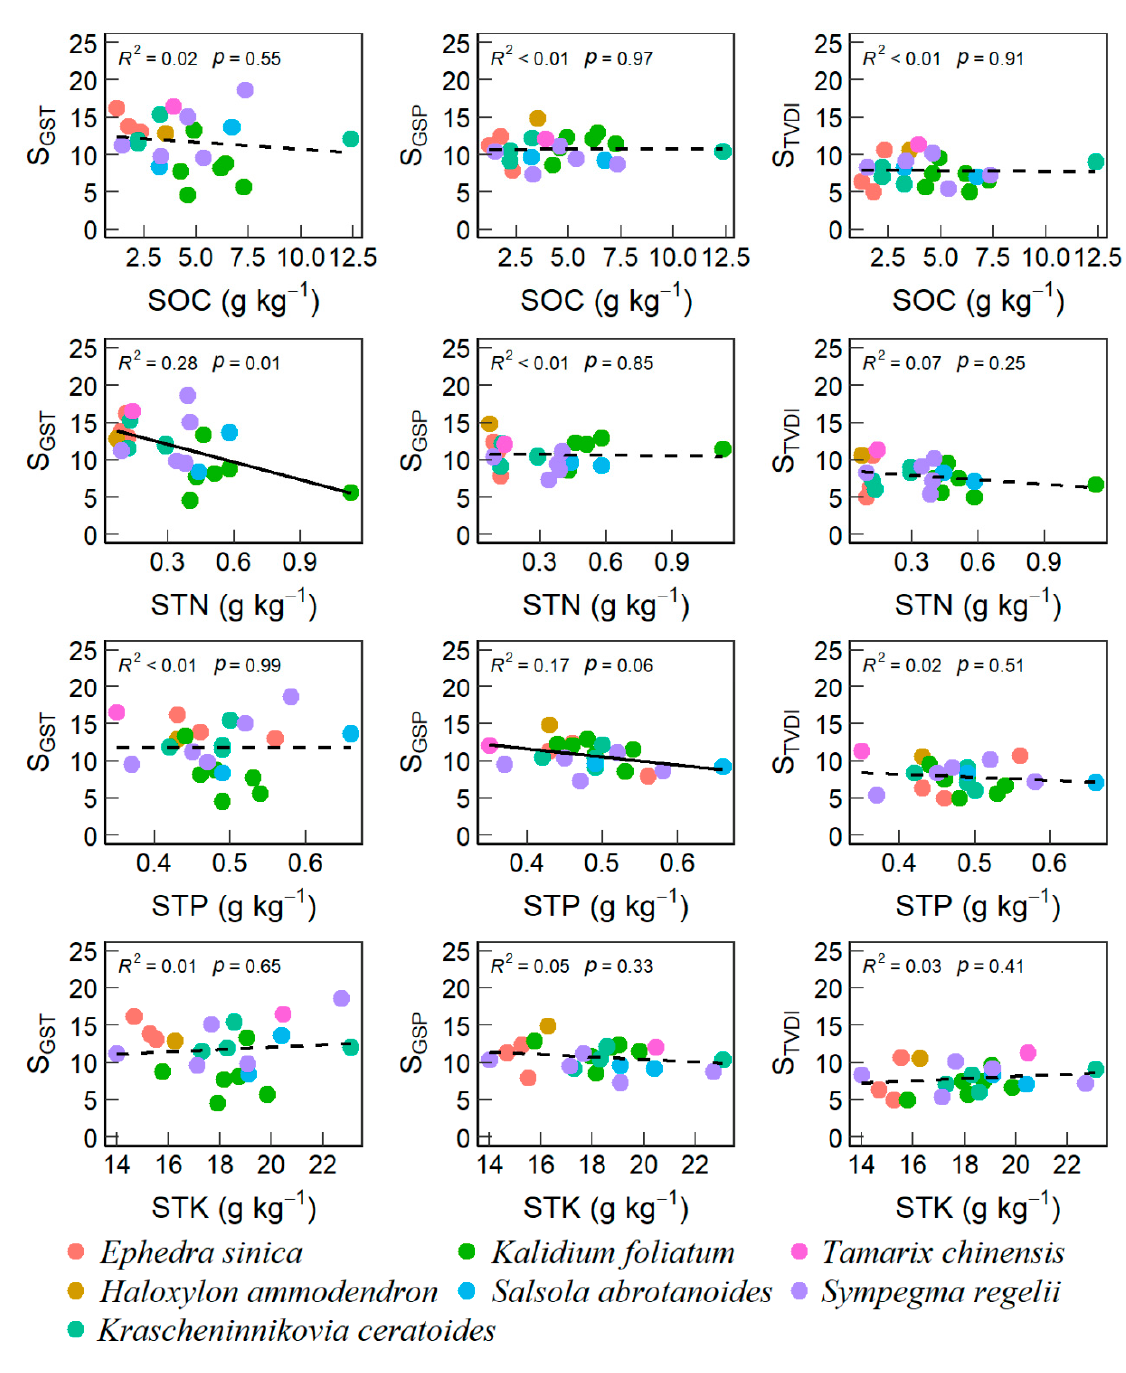
Figure 4. Trends of vegetation sensitivity index and its contributions with soil nutrients.